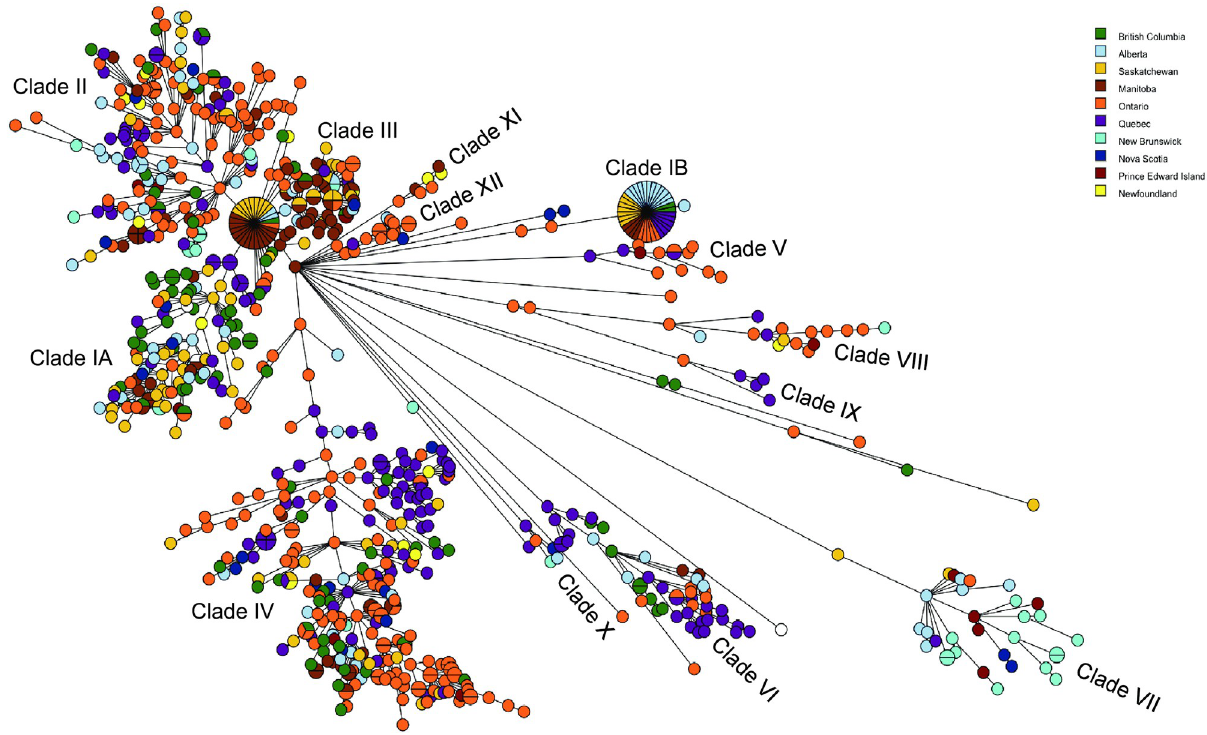
Fig 6. Mapping of isolates by province of origin. A full wgMLST UPGMA dendrogram (S1 Fig) was used to create this MST.